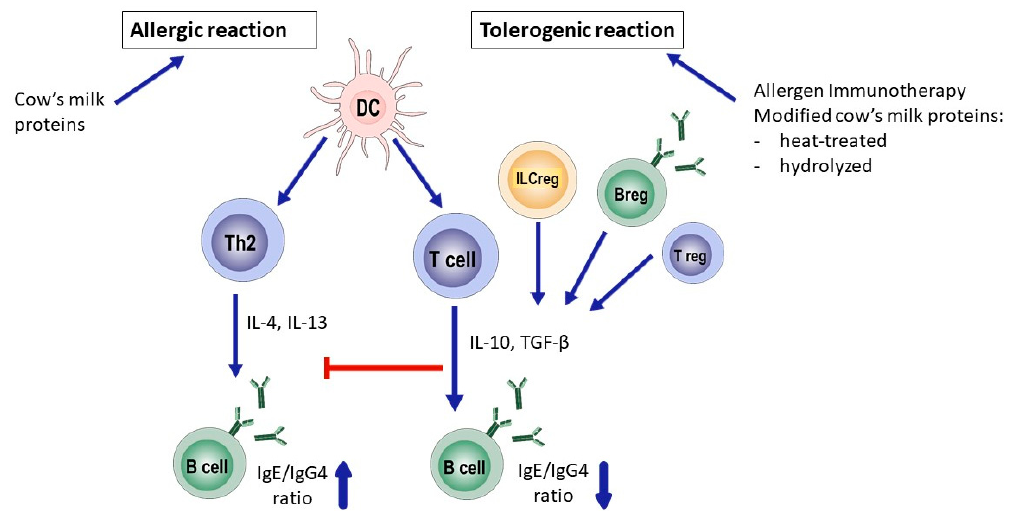
Figure 1. Immune response in the allergic versus tolerant state for cow’s milk proteins. Breg: B-regulatory cell; DC: Dendritic cell; ILCreg: Regulatory innate lymphoid cells; IL: interleukin; TGF- β : transforming growth factor B è ta; IgG4: Immunoglobulin G 4; IgE: immunoglobulin E; Treg: T regulatory cell; Th2: T- helper 2 cell